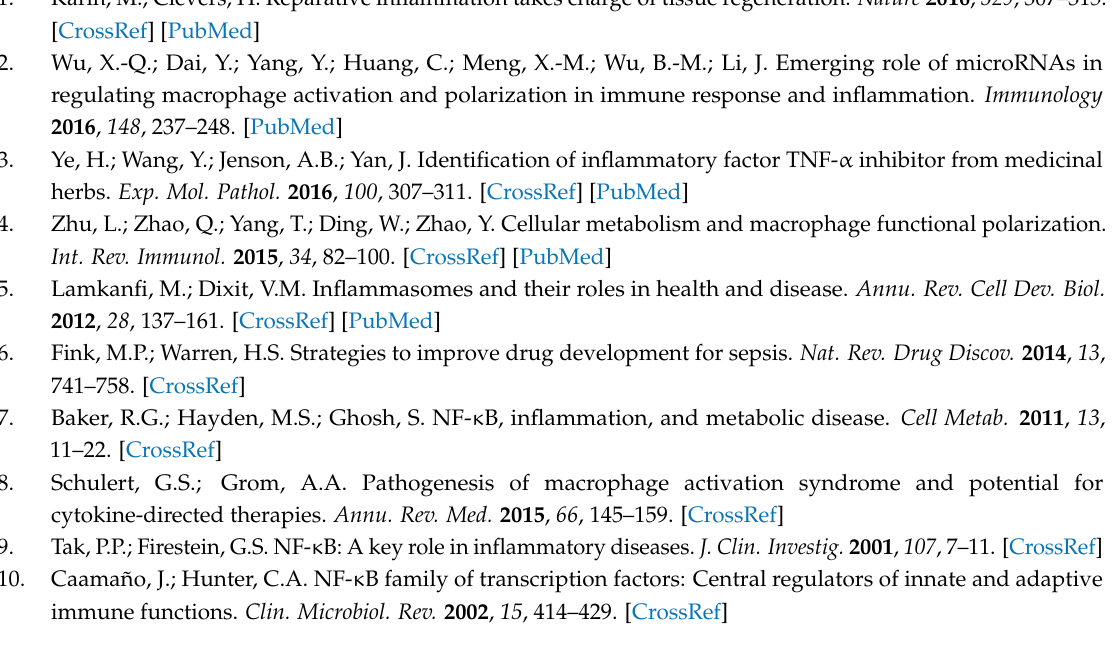
Supplementary Materials: The following are available online. Figure S1: ESI-MS spectrum of pillion, Figure S2: 1 H-NMR spectrum of pillion (CDCl 3 , 500 MHz), Figure S3: The effect of pilloin on serum biochemical markers in